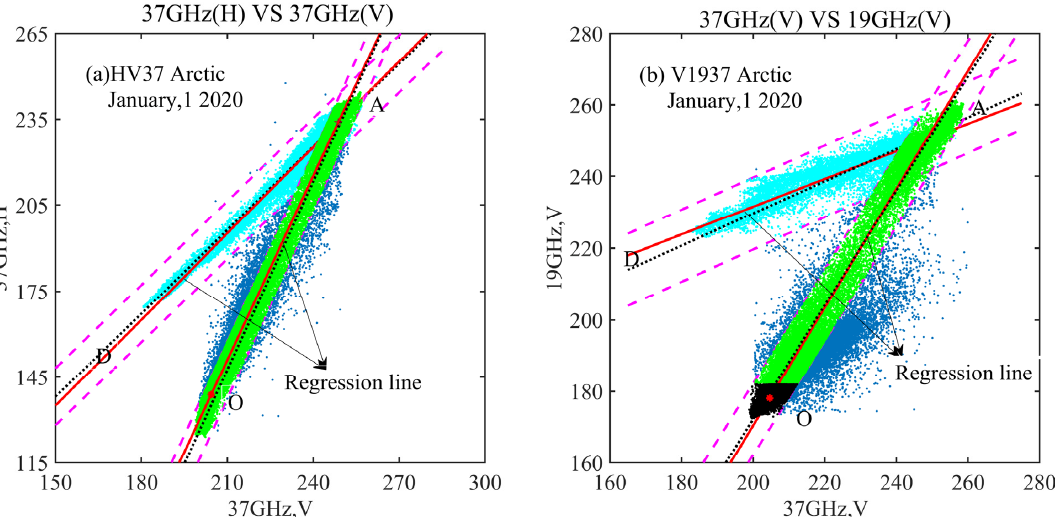
Figure 4. Selection of tie-points for the BT algorithm. ( a ) Polarization mode. ( b ) Frequency mode. The black dashed lines AD and AO represent the lines formed by the initial points. Magenta dashed line indicates the result of AD or AO ± 10 K. The red line indicates the result of the linear regression of AD or AO.